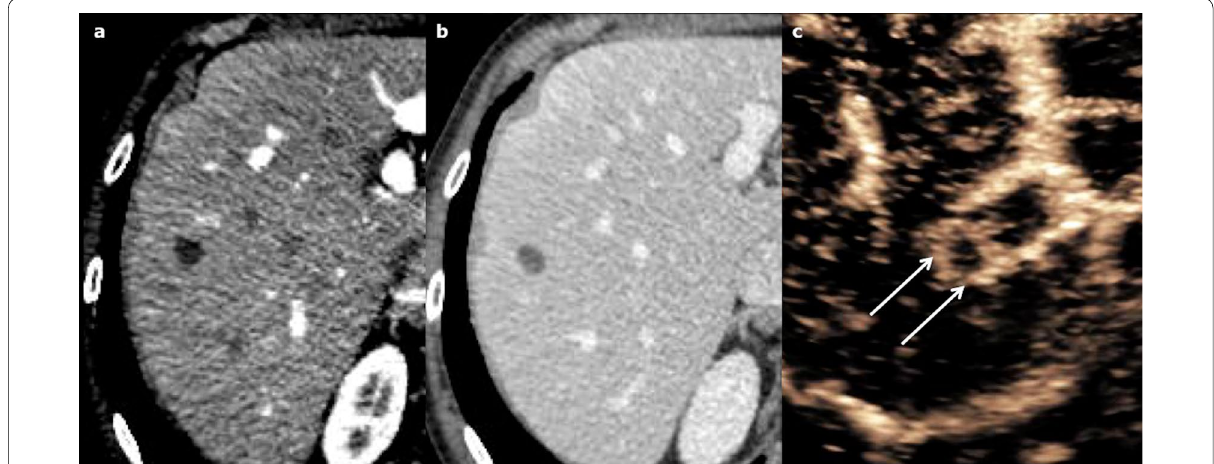
Fig. 22 Cystic metastasis from malignant melanoma in a 72-year-old female. a , b Axial computed tomography on arterial and portal venous phases shows unique hypoattenuating (20 Hounsfield Units) nodule of the right liver lobe, too small to be characterised. c Contrast-enhanced ultrasonography displays an enhanced wall as a “rim” (arrows)